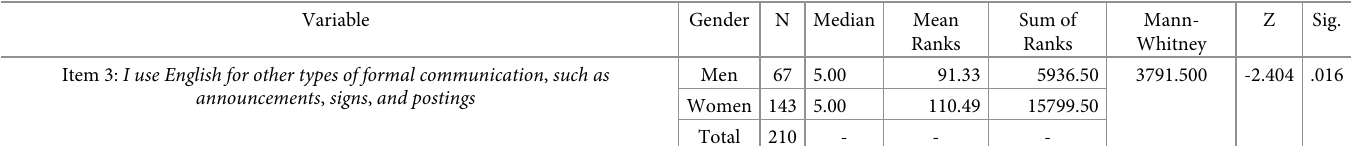
Table 6. Mann-Whitney test.